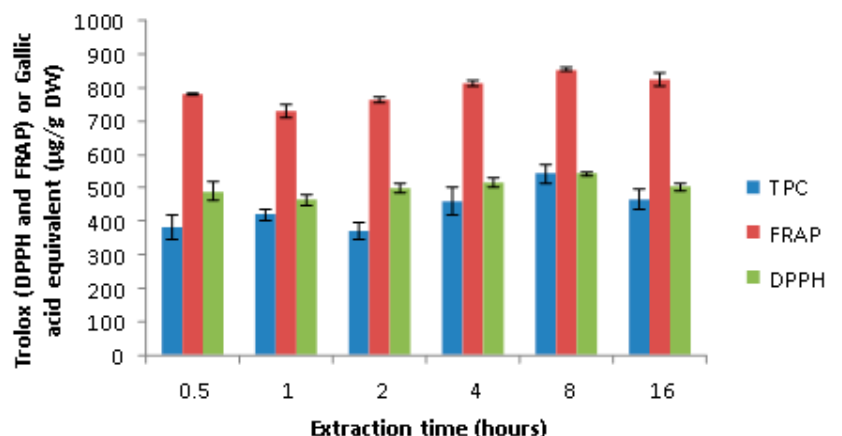
Figure 3. Effect of time of extraction on the antioxidant activity and total phenol content of yellow onion extract.